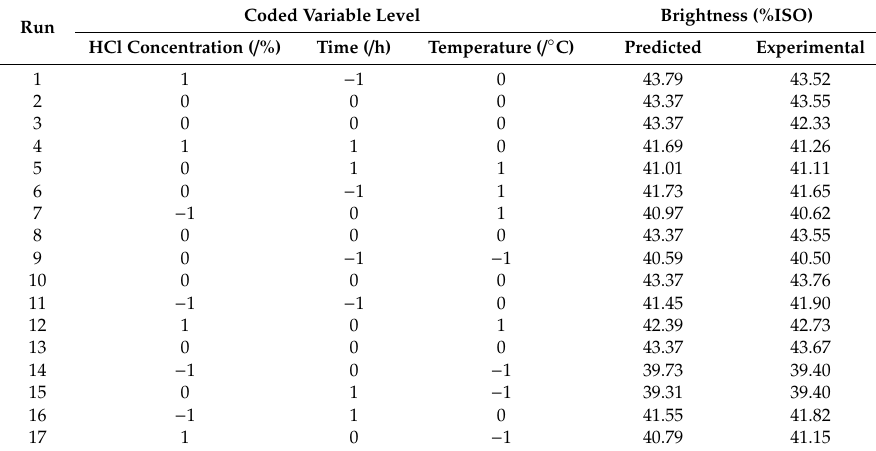
Table 4. Response surface analysis test design and